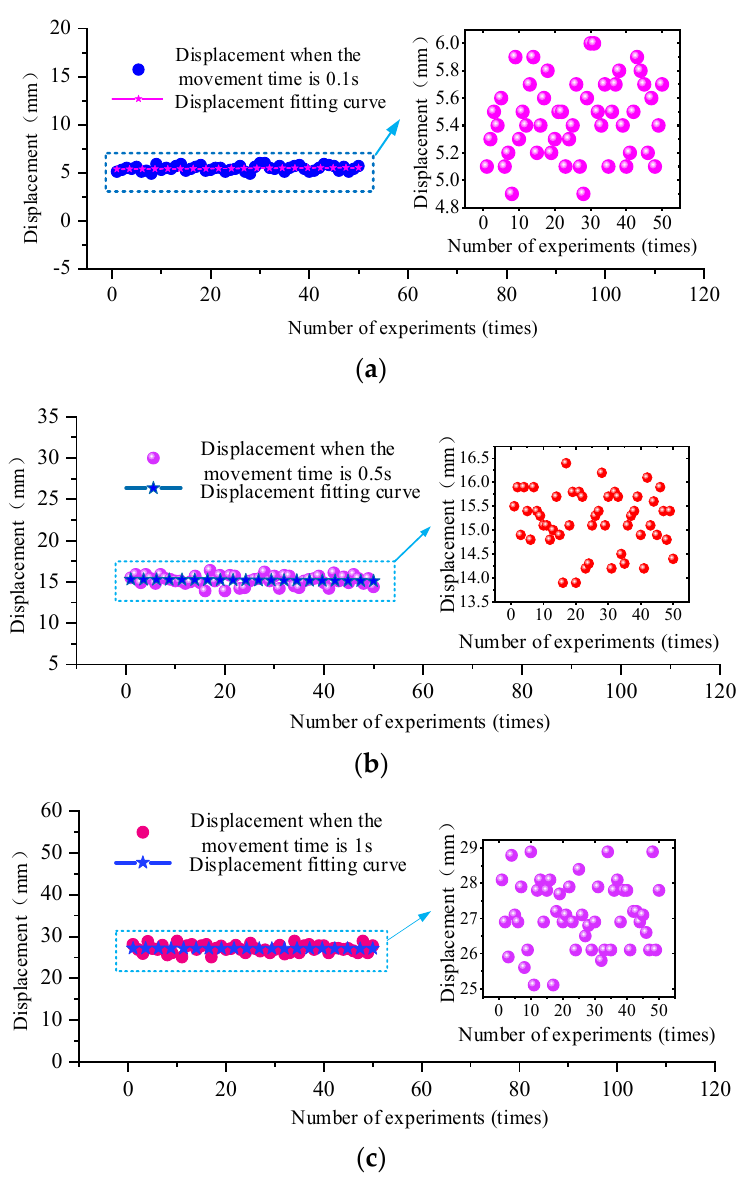
Figure 12. Variation curve of displacement with time during column lowering movement of the column cylinder of hydraulic support. ( a ) shows the displacement fitting curve under the condition of multiple experiments and movement time of 0.1 s; ( b ) shows the displacement fitting curve under the condition of multiple experiments and movement time of 0.5 s; ( c ) shows the displacement fitting curve under the condition of multiple experiments and movement time of 1 s.